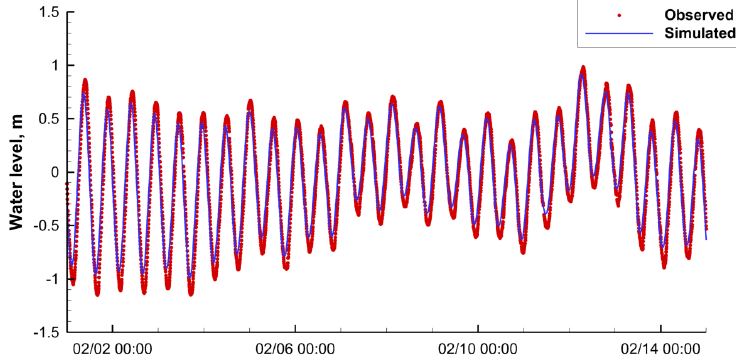
Figure 5. Comparison of simulated (hindcast) and observed water levels at Vilano Beach station for tidally-dominated flow.